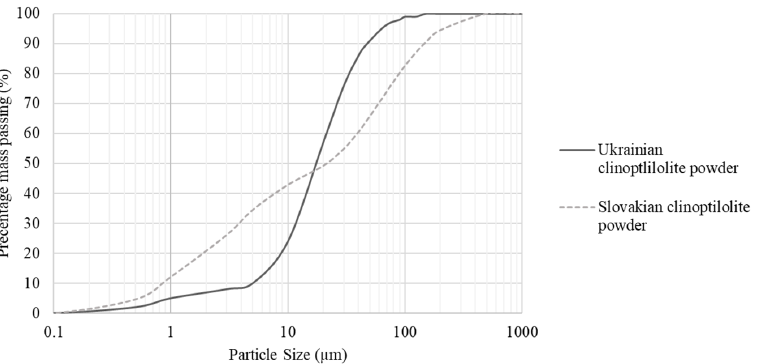
Figure 7. Particle size distribution curves of Ukrainian and Slovakian clinoptilolite powders used in the compaction process.